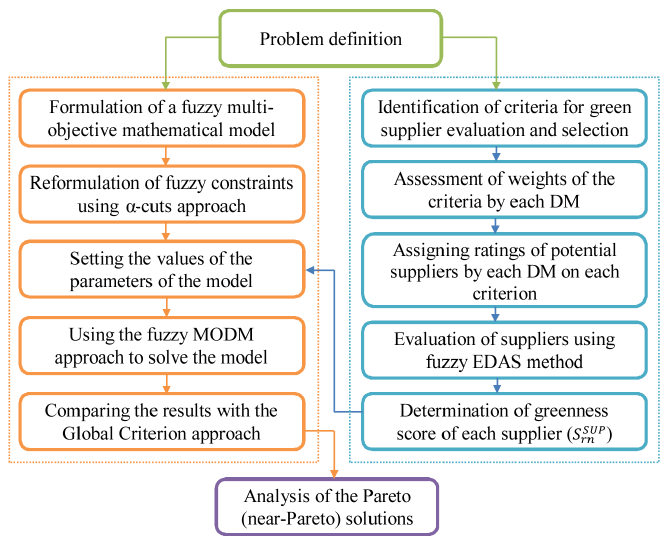
Fig. 2. The framework of the solution